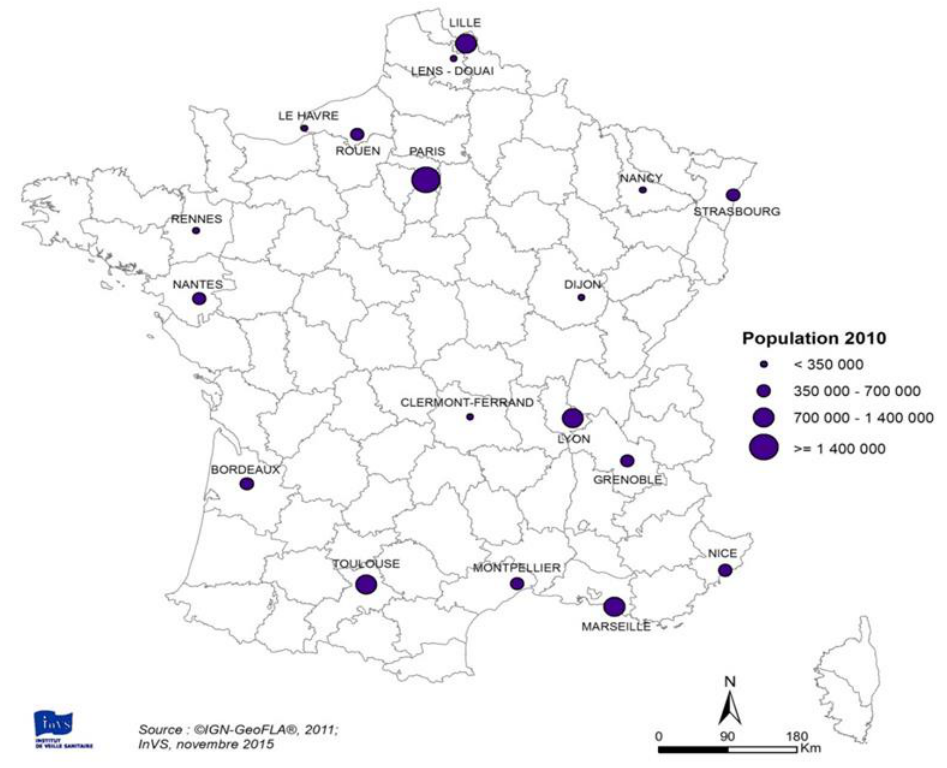
Figure 1. Map of 18 study areas and relative population sizes.